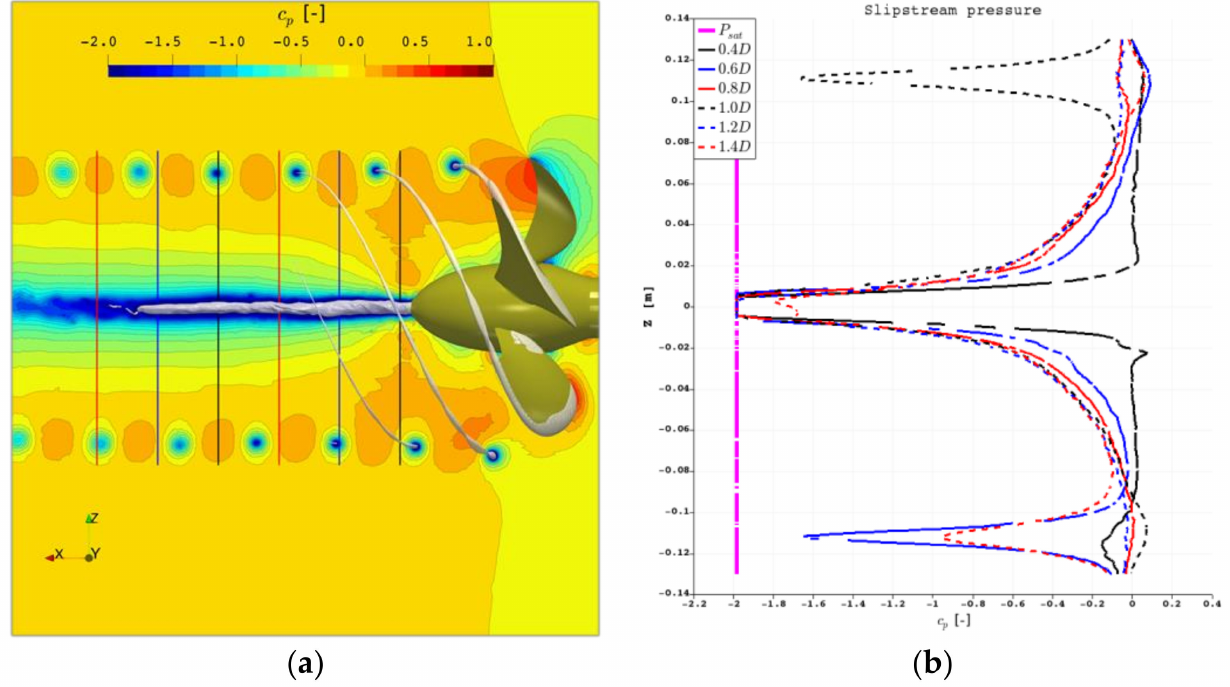
Figure 10. PPTC’11. Pressure distribution in the slipstream: ( a ) pressure contours in midplane with investigated lines; ( b ) pressure plots along investigated